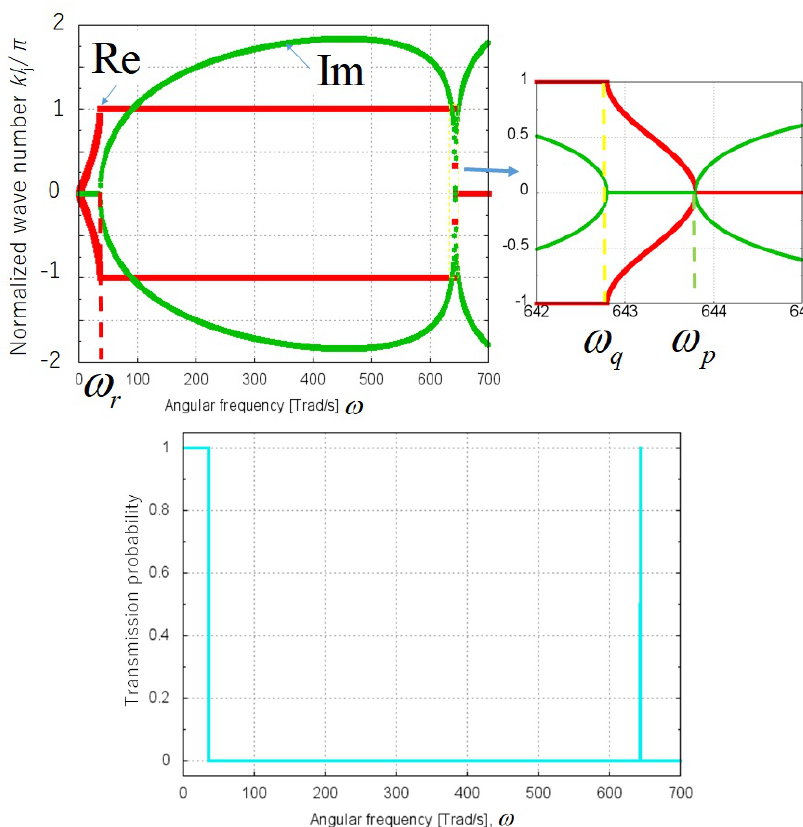
Figure 4. Complex dispersion curves ( upper ) and transmission probability spectrum of the phonon ( lower ). The upper right inset plots enlarged dispersion curves in the frequency range of 642–645 Trad/s.